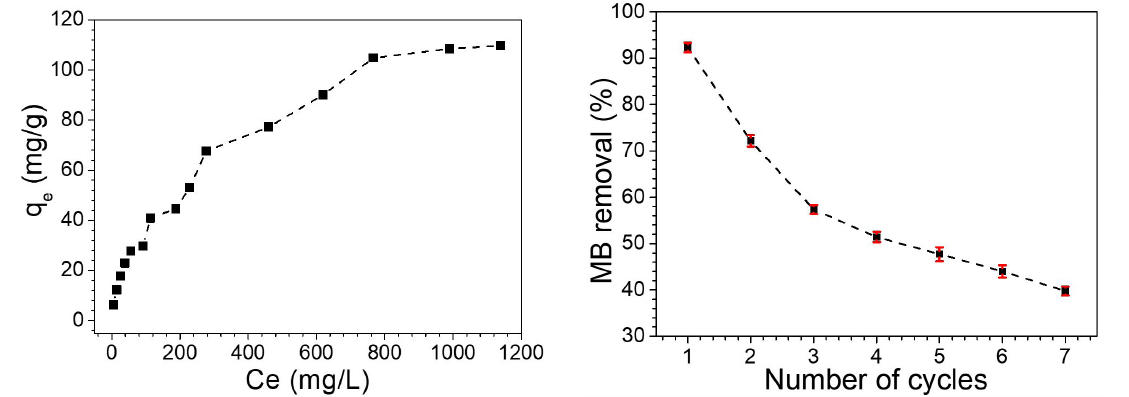
Figure 13. Isothermal adsorption curve of the MB dye in the PMF-Si hydrogel follows the Langmuir adsorption model.